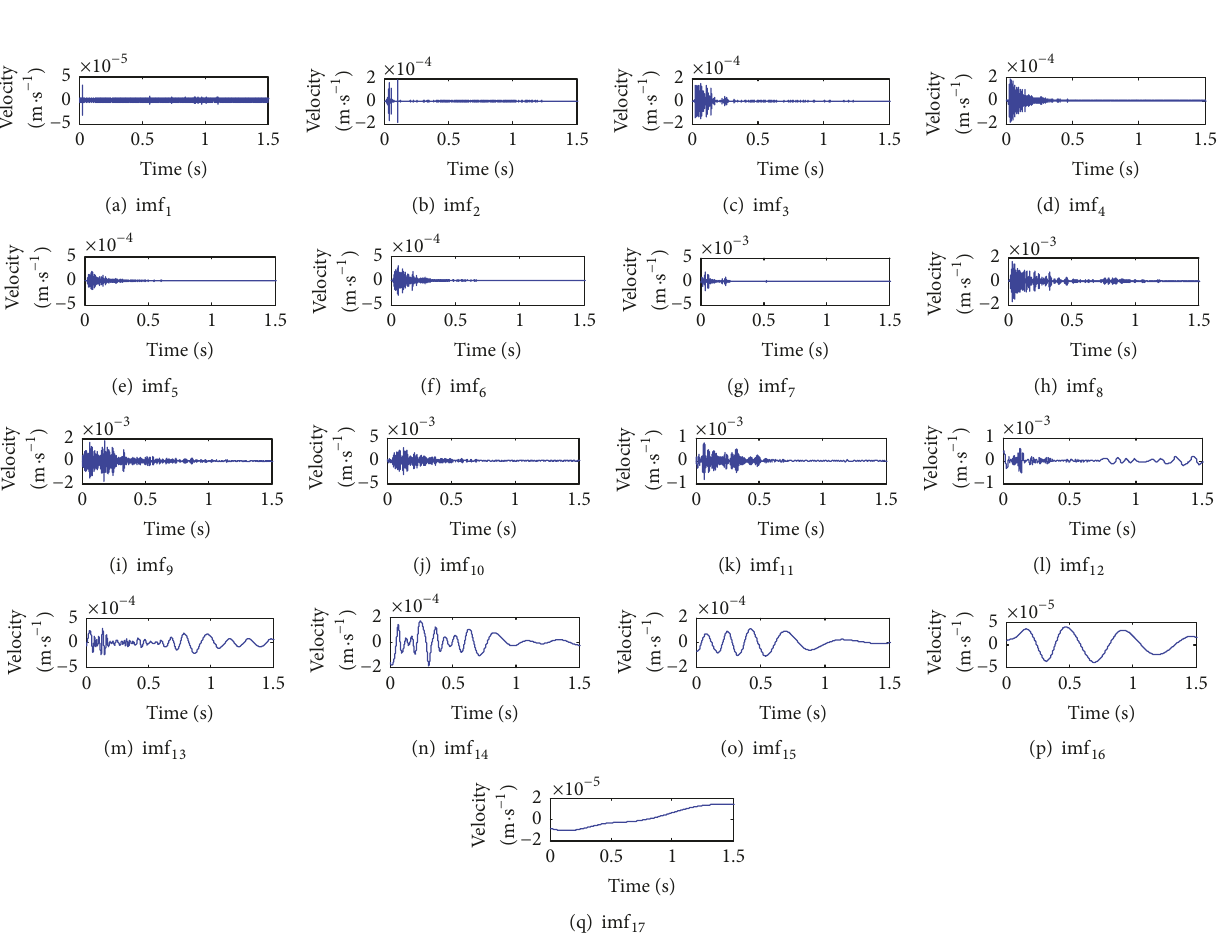
Figure 8: IMF components of the vibration velocity at the outer surface of explosive